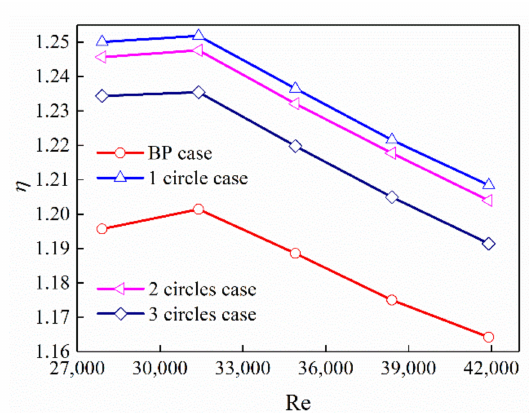
Figure 19. Variation of comprehensive heat transfer factor with